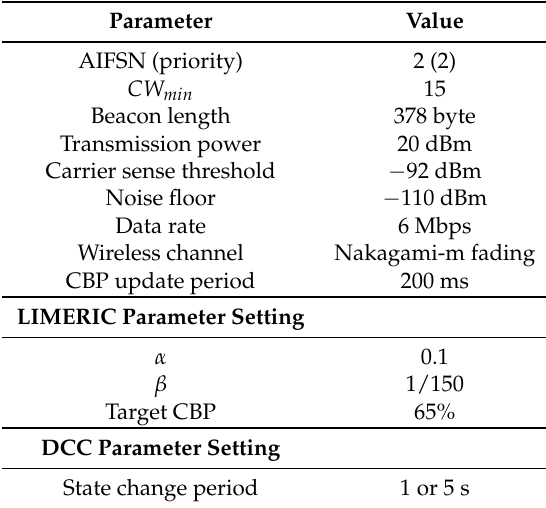
Table 2. Parameter setting of simulation